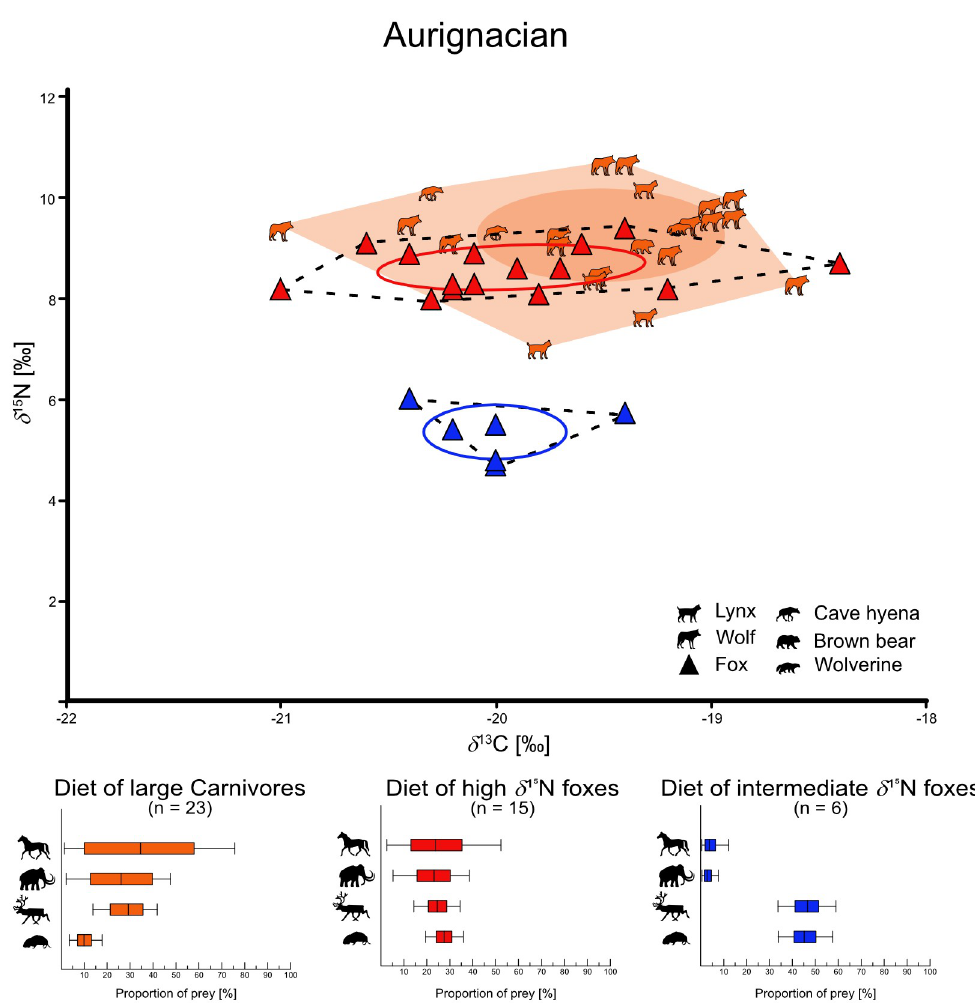
Fig 4. Trophic niches in the Aurignacian. Calculated trophic niches of foxes (Triangles) and large carnivores (shapes) from the Aurignacian with SIBER. Dashed lines in the fox niches as well as light collard area in the large carnivore group show the convex hull (outline of the niches). The solid lines in the fox niches and the dark collard ellipses in the carnivore group show the calculated Standard Ellipse Area (SEA) and reflect the core niches, based on Bayesian statistics. In the lower part of the figure is the reconstructed diet given. Diet proportions calculated with MixSIAR of each fox niche and the large carnivore group. Solid lines show the 5 to 95% confidence interval, full boxes show the 25 to 75% confidence interval and vertical black line shows the median